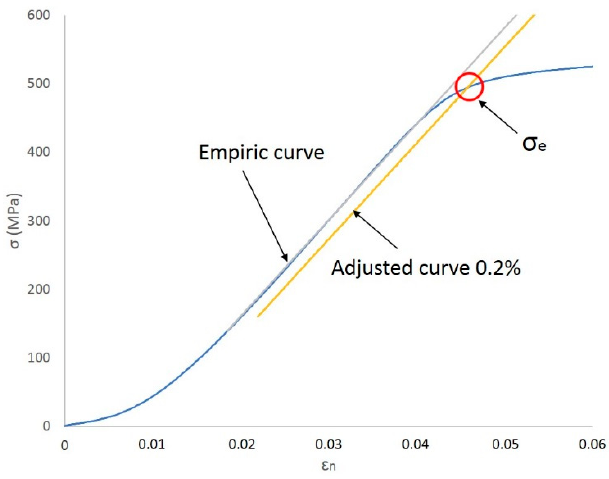
Figure 5. Elastic limit in an adjusted curve.